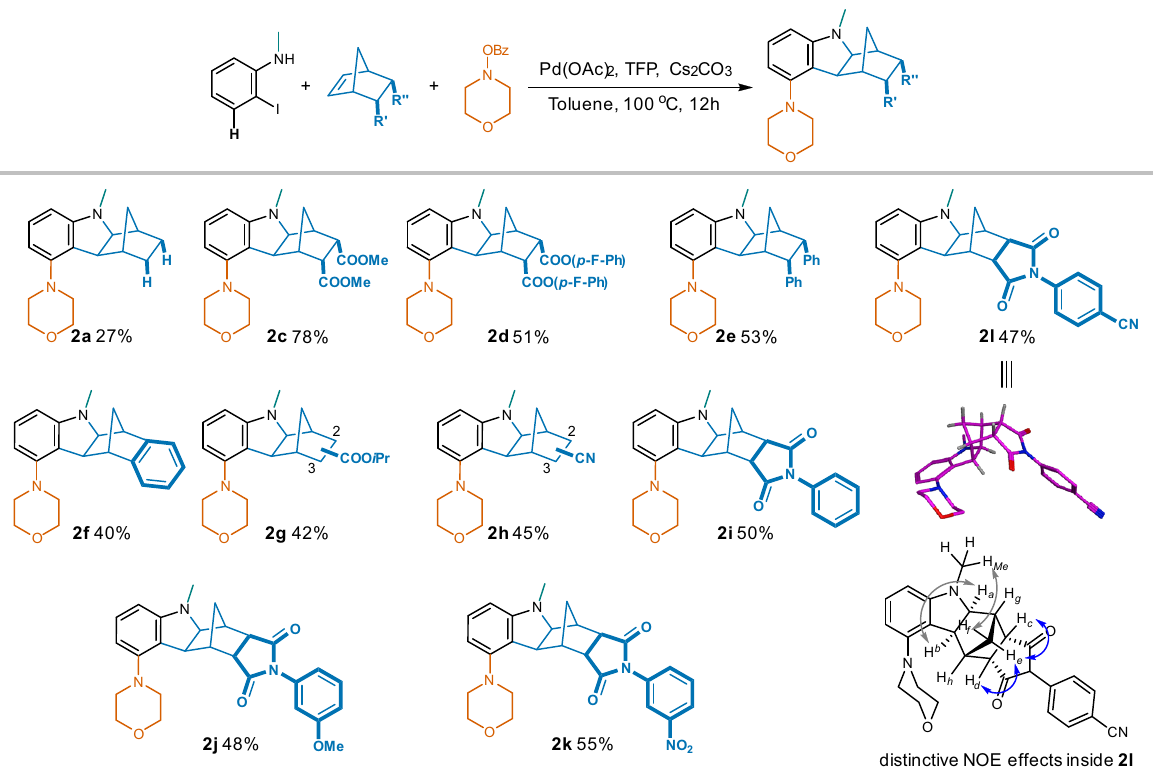
Fig. 4 In fl uences of NBE substitutions in synthesizing the corresponding 5-substituted hexahydro-1 H -1,4-methanocarbazoles. Reaction conditions: 2- iodo- N -methylaniline (1.0 eq.), NBE analog (1.0 eq.), morpholino benzoate (1.3 eq.), Pd(OAc) 2 (5% eq.), TFP (10% eq.), Cs 2 CO 3 (2.5 eq.), toluene, 100 o C, 12